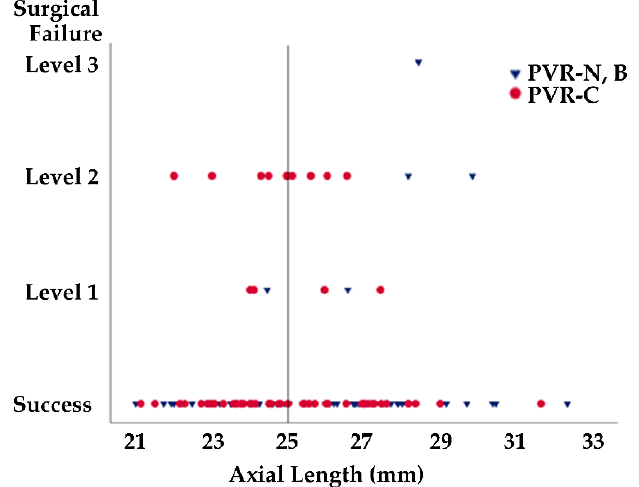
Figure 1. Scatter diagram representing the relationship between axial length and surgical fail- ure/success in the propensity-matched cohort. PVR, proliferative vitreoretiopathy; N, None; B, grade B; C, grade C.